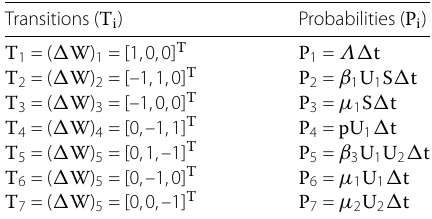
Table 1 Transition